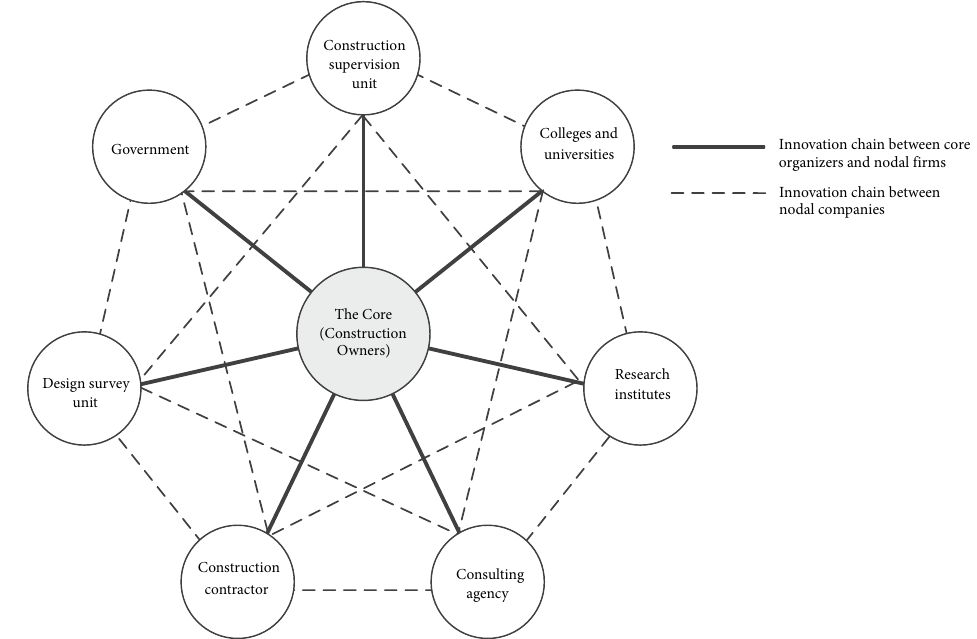
Figure 1. Cross-organizational collaborative network of technological innovation in megaprojects